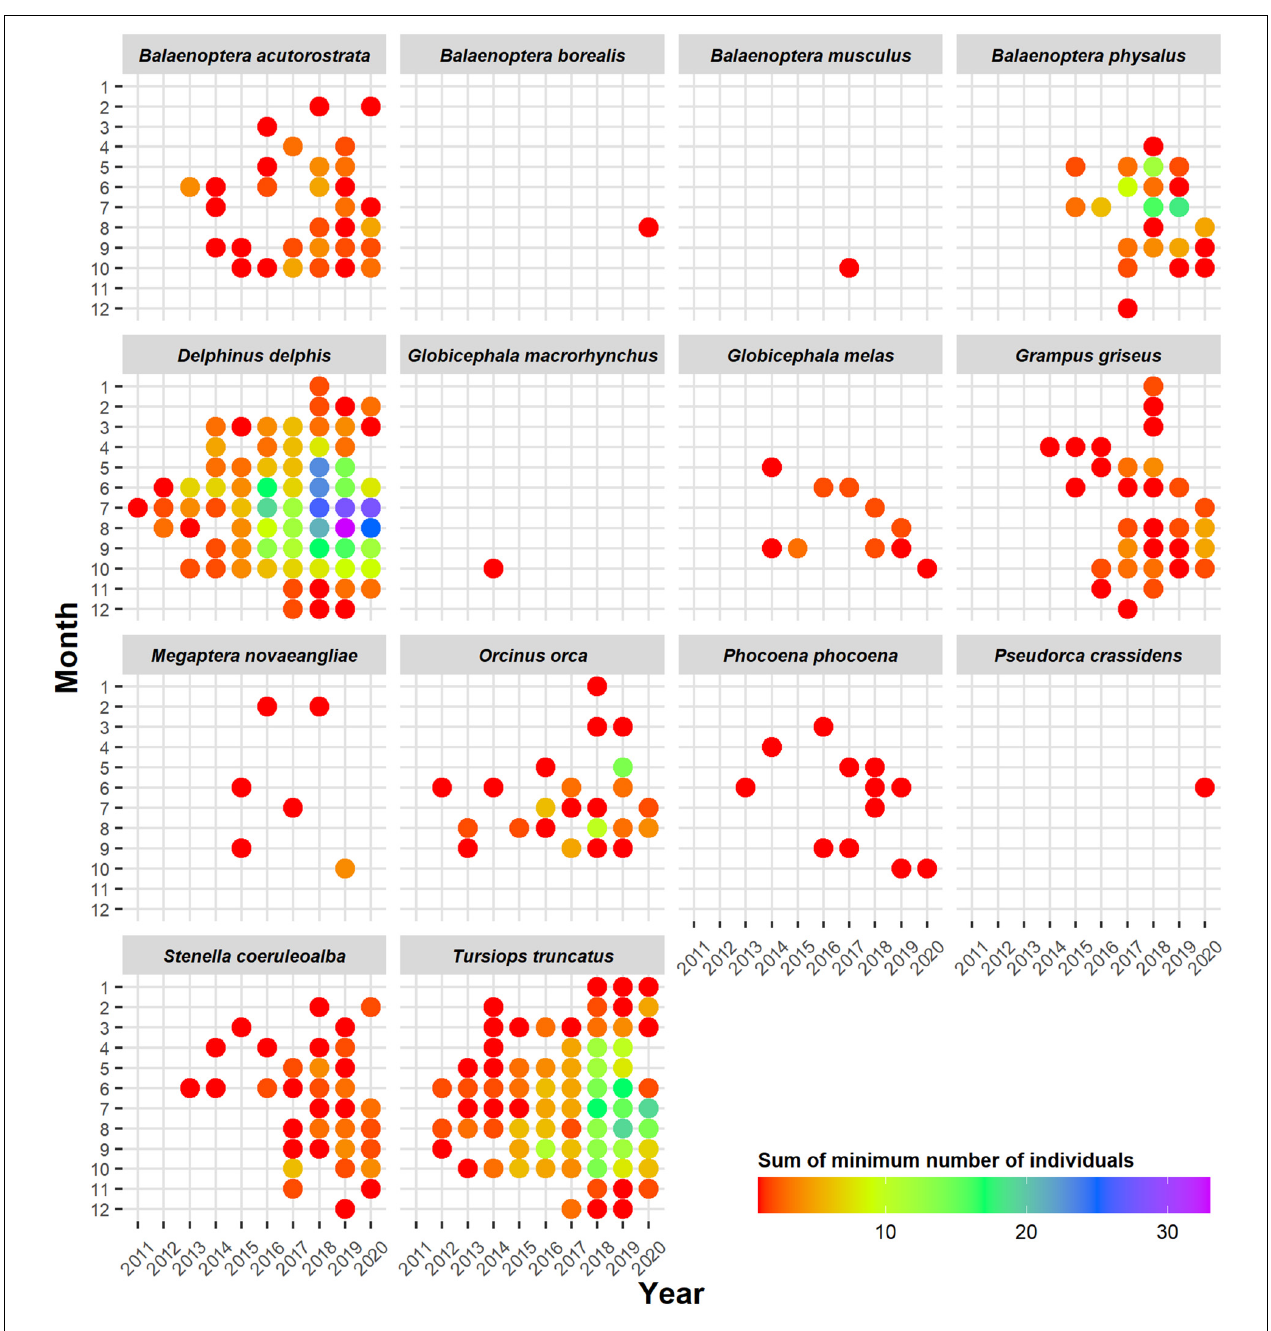
FIGURE 5 | Monthly sum of the minimum number of individuals of each cetacean species shown on social media posts published between 2011 and 2020 in the Facebook and Instagram accounts of whale-watching companies from the Algarve (Portugal).